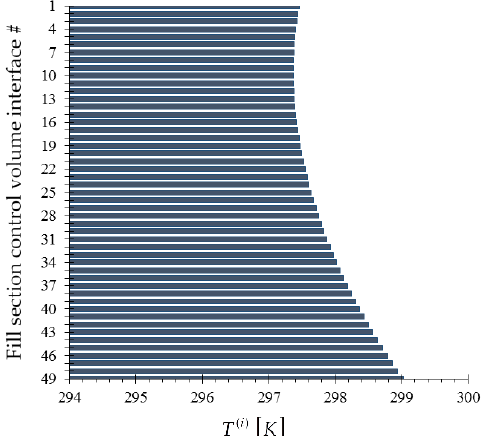
Figure 6. Bar plot of the air temperatures ( ) i T the height of the fill section of the cooling tower.